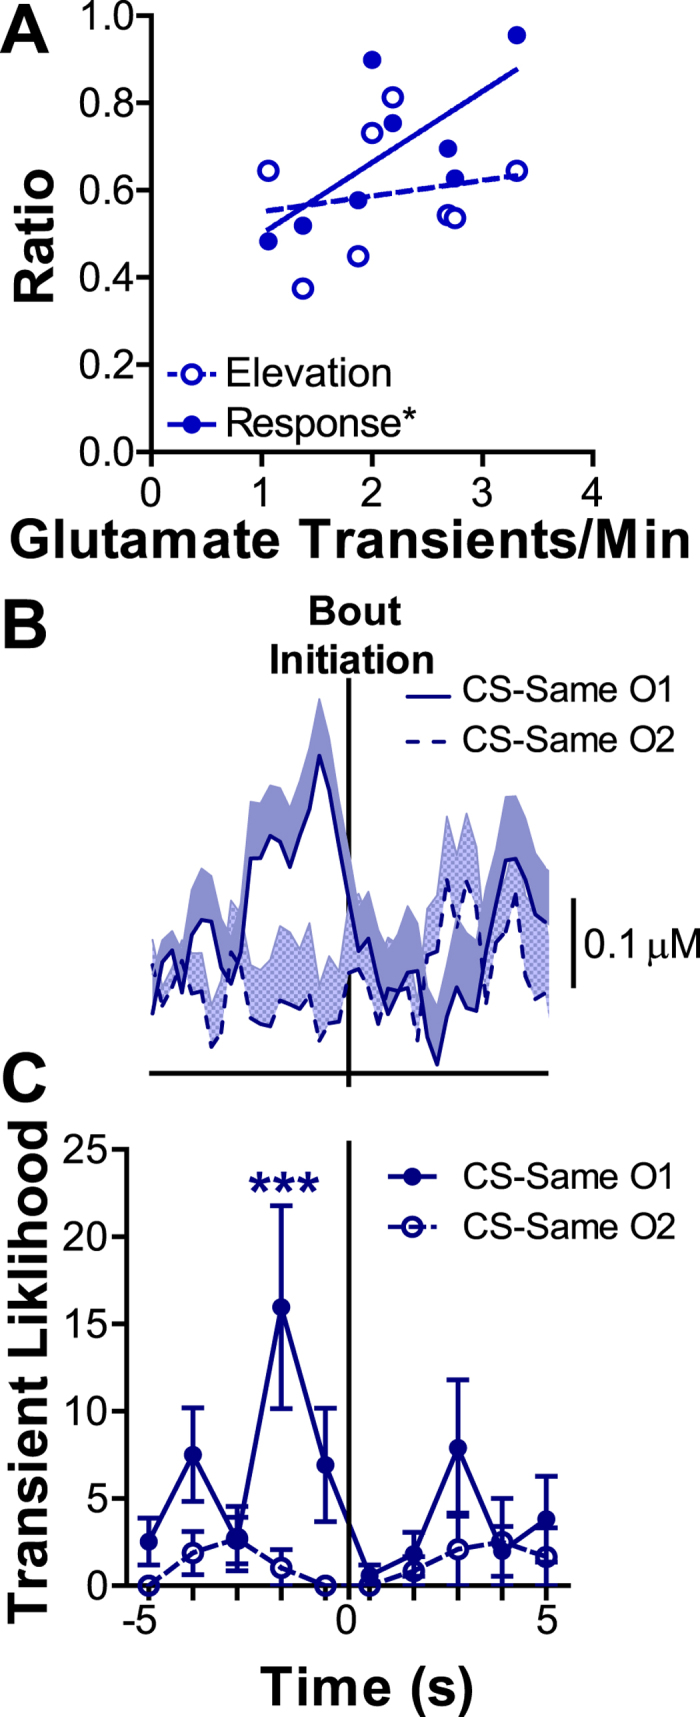
Outcome specificity of basolateral amygdala glutamate release during Pavlovian-instrumental transfer.(A) Between-subjects correlation between glutamate transient frequency (Transients/min) and elevation [CS pressing/(CS + Pre-CS pressing)] v. response [CS-Same/(CS-Same + CS-Different)] ratio. (B) Glutamate concentration v. time traces for the 5 s prior to and after initiating presses (occurring at time 0 s) was averaged across all CS-Same initiating presses during the PIT test for the same representative subject as in 4F. Traces are divided by the type of outcome the action earned. Shading reflects the +1 SEM across trials. (C) The likelihood of a glutamate transient distributed in 1-s bins, 5 s prior to and after CS-Same initiating presses (occurring at time 0 s). Data are divided by the two CS-Same trial types. O1: Outcome 1 is defined as the outcome earned by the action that was exclusively (for 6/8 subjects) or preferentially (for 1/8 subjects) preceded by transient glutamate release. For the single subject in which he glutamate signal did not distinguish between outcome types outcome 1 was randomly assigned to the grain pellet outcome. Likelihood of a glutamate transient is defined as the percentage of initiating presses that had a glutamate transient in the represented 1-s time bin. Asterisks represent significance relative to the control 1-s time bin 5 s prior to the press. *p < 0.05, ***p < 0.001.